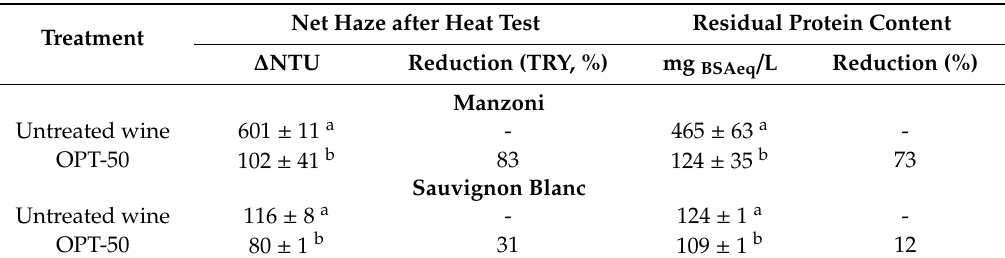
Table 5. Protein stability data of Manzoni and Sauvignon blanc white wines, treated in a laboratory-scale stirred reactor with papain immobilized on OPT-50 carrier at 20 ◦ C (120 rpm, 24 h). Reported data are mean of triplicate